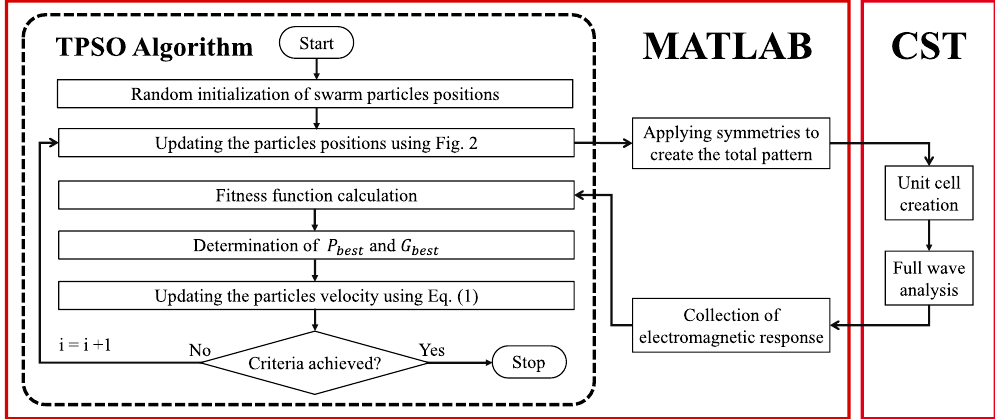
Figure 1. Flowchart of the TPSO-based unit-cell design